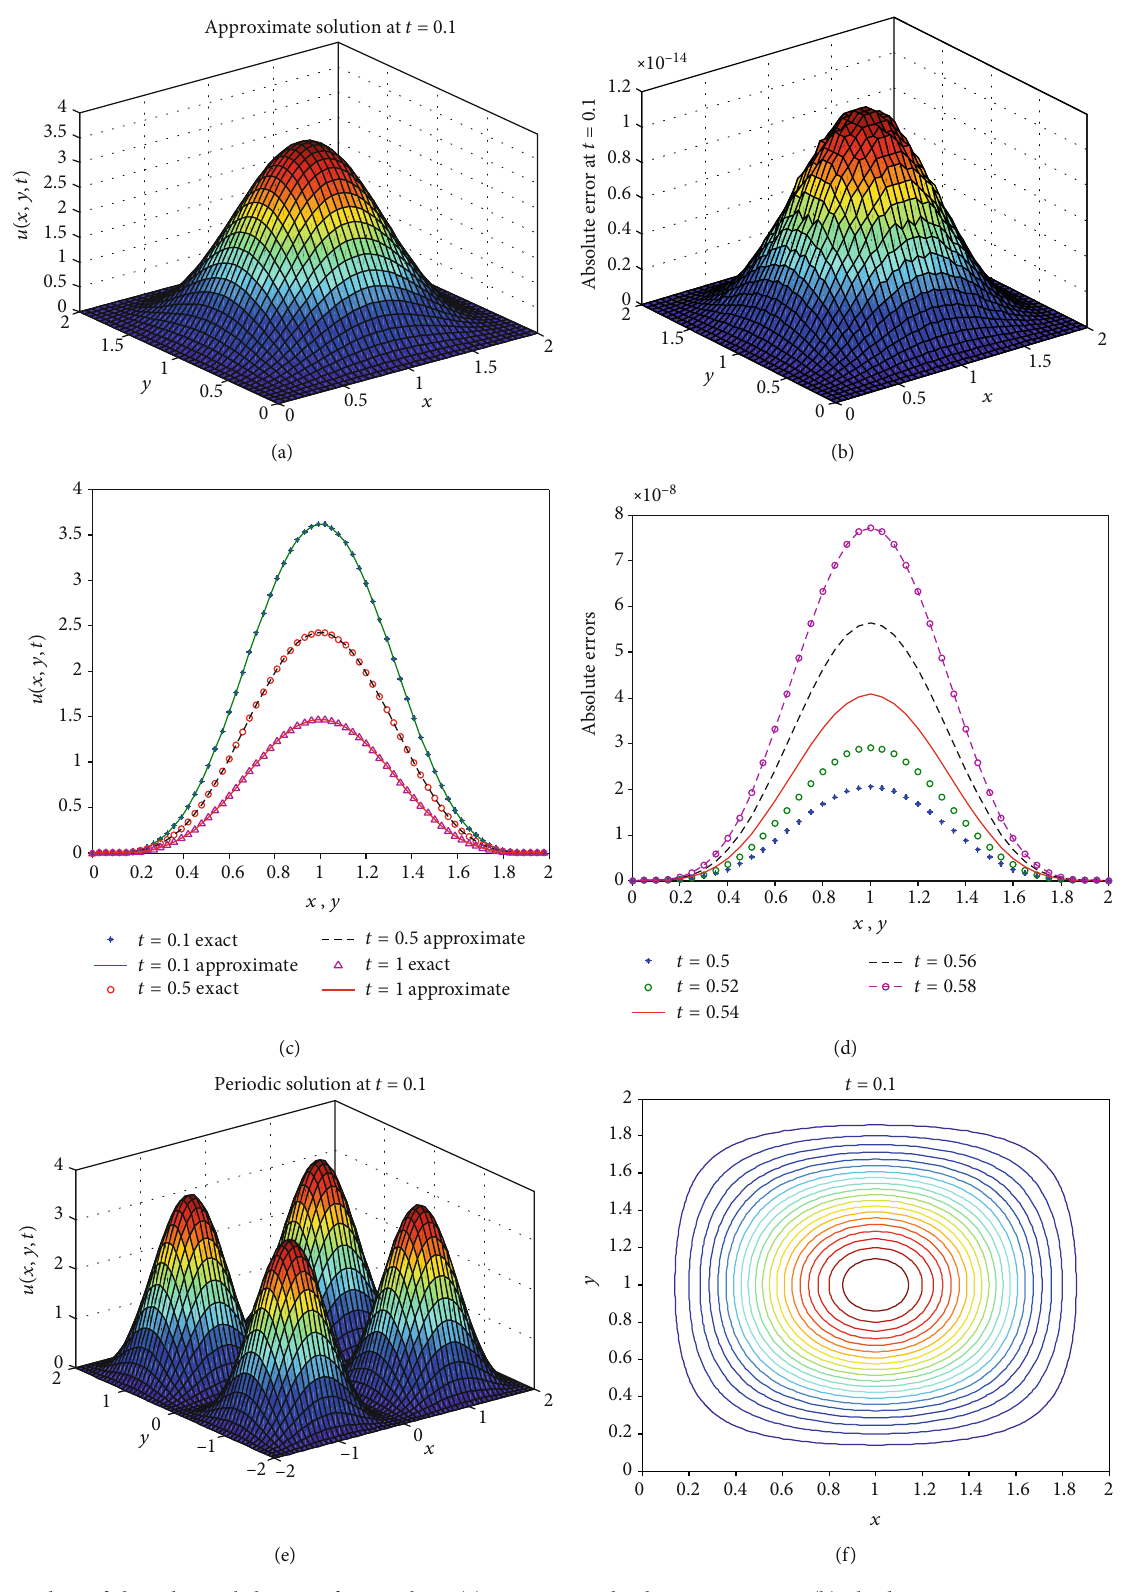
Figure 2: Plots of the solution behavior of Example 2: (a) approximated solutions at t = 0 : 1 ; (b) absolute errors at time at t = 0 : 1 ; (c) comparison of exact and approximated solutions for times t = 0 : 1 , 0.5, 1; (d) comparison of absolute errors for di ff erent values of times t = 0 : 5 , 0.52, 0.54, 0.56, 0.58; (e) the periodic nature of the solution; and (f) the soliton at t = 0 :